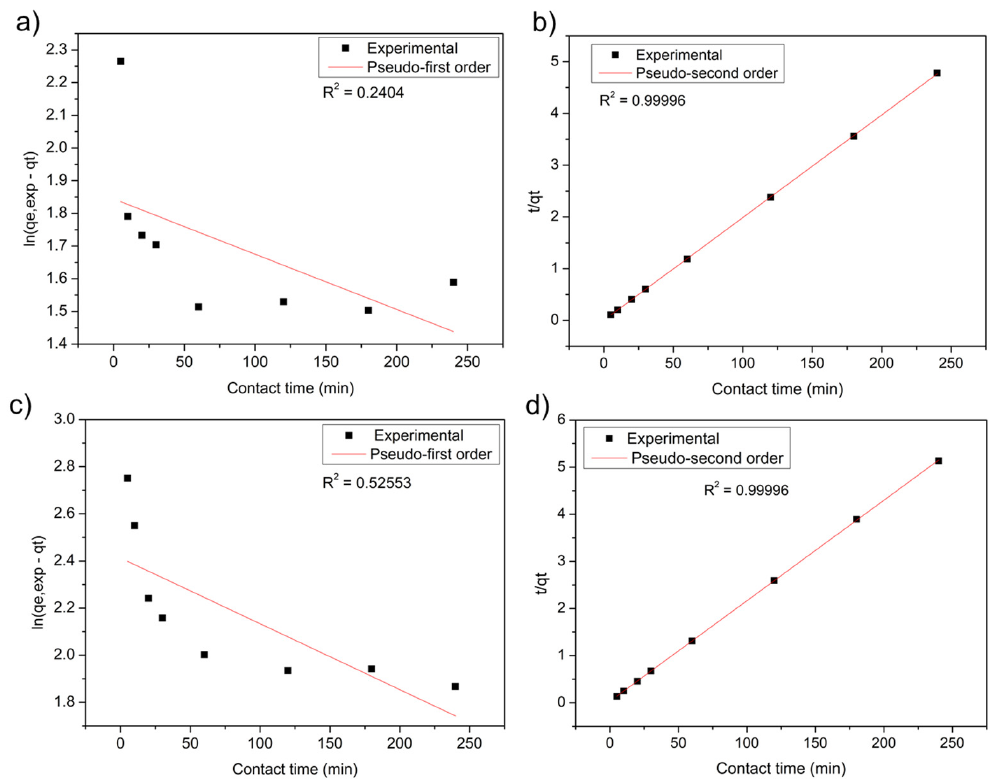
Figure 5. Adjustment to the kinetic model for the stem: ( a ) pseudo-first- and ( b ) pseudo-second-order for the MB in contact with the biomass. For the leaf: ( c ) pseudo-first- and ( d ) pseudo-second-order for the MB in contact with the biomass.